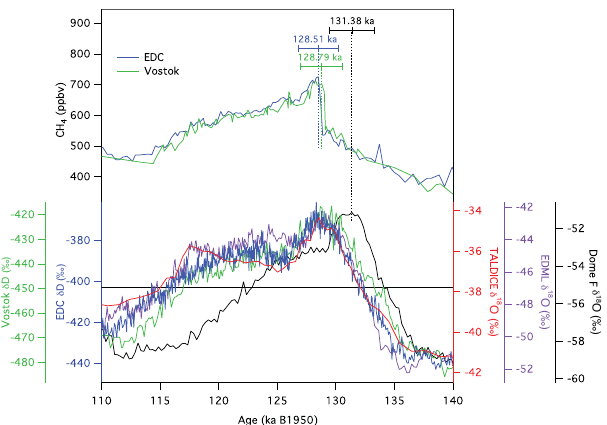
Fig. 7. Bottom: comparison of MIS 5.5 duration in several ice cores. The EDC, Vostok, EDML and TALDICE isotopic records are on AICC2012 age scales. The Dome F δ 18 O is on the DFO- 2006 chronology (Kawamura et al., 2007). The black horizontal line corresponds to the − 403‰ interglacial threshold on EDC. Top: methane records of Vostok and EDC. Termination II ages are de- fined from the timing of the sharp methane rise for EDC (blue) and Vostok (green), and the water stable isotope optima for Dome F